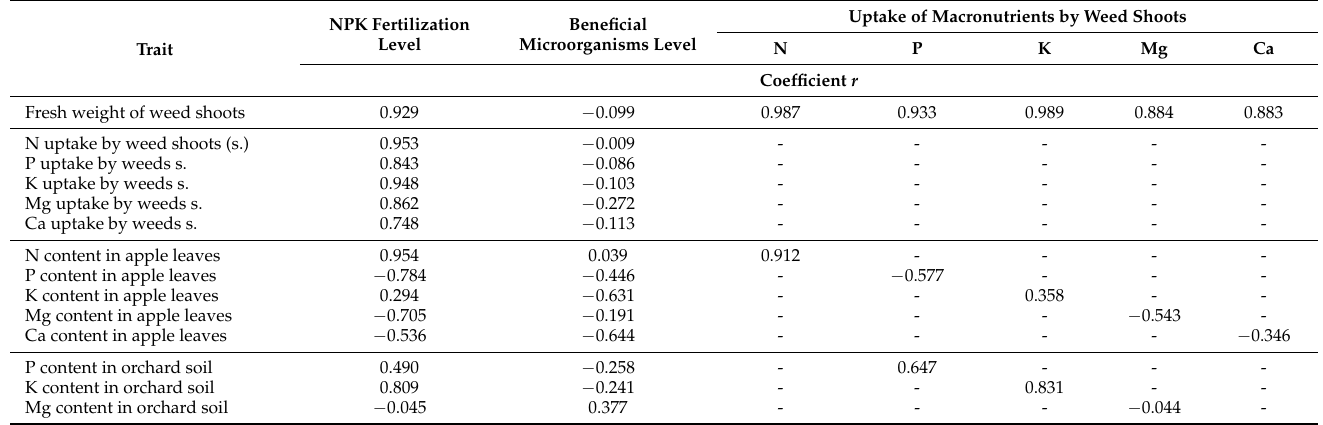
Table 13. Selected correlation coefficients between NPK fertilization level, beneficial microorganism level, fresh weight of weeds, macroelements uptake by weeds and macroelements content in apple leaves and orchard